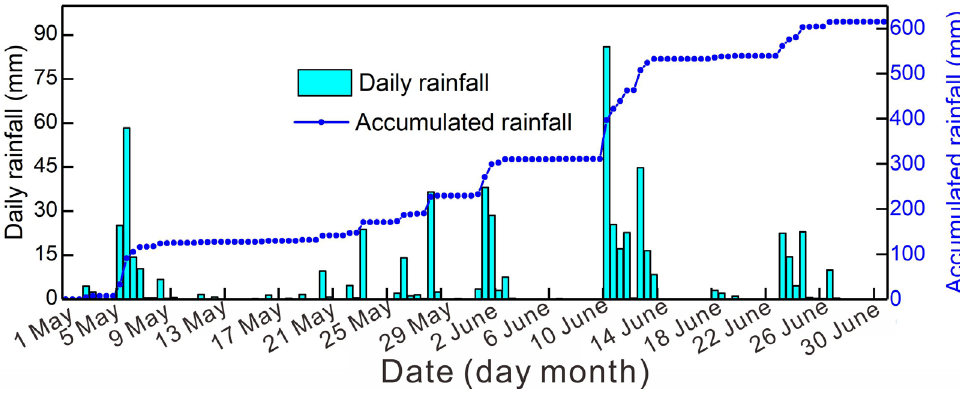
Figure 7. Data of the rainfall every 12 h from the national rainfall stations in the study area from 1 May to 30 June.